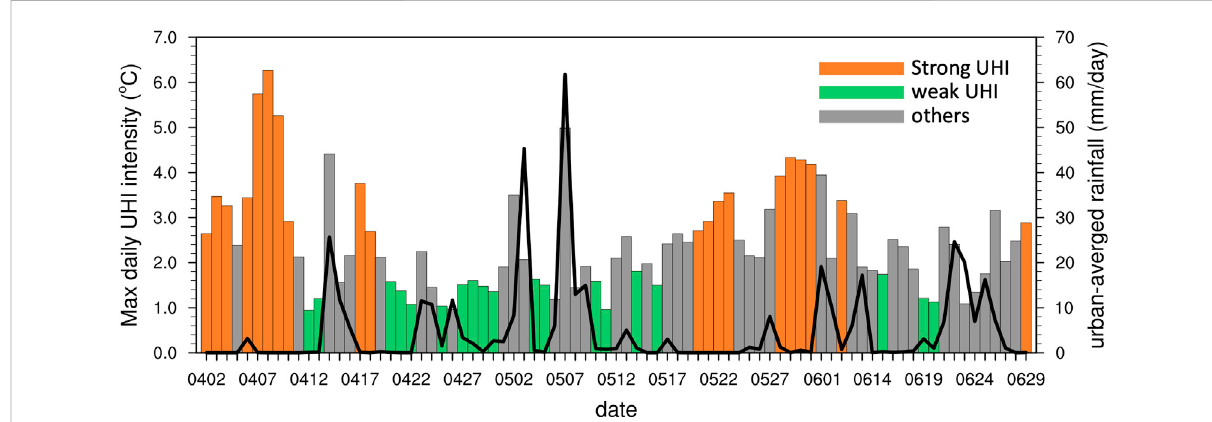
FIGURE 2 The evolution of the observed daily maximum urban heat island intensity (urban minus rural; colored bars on left axis) and the daily average rainfall over the urban region (black line on right axis) from 2nd April to 29th June, excluding the days when tropical cyclones made landfalls (5th to 12th June). The orange (green) bars indicate strong (weak) UHI days without daily rainfall accumulation exceeding 5 mm/day. The gray bars indicate the remaining